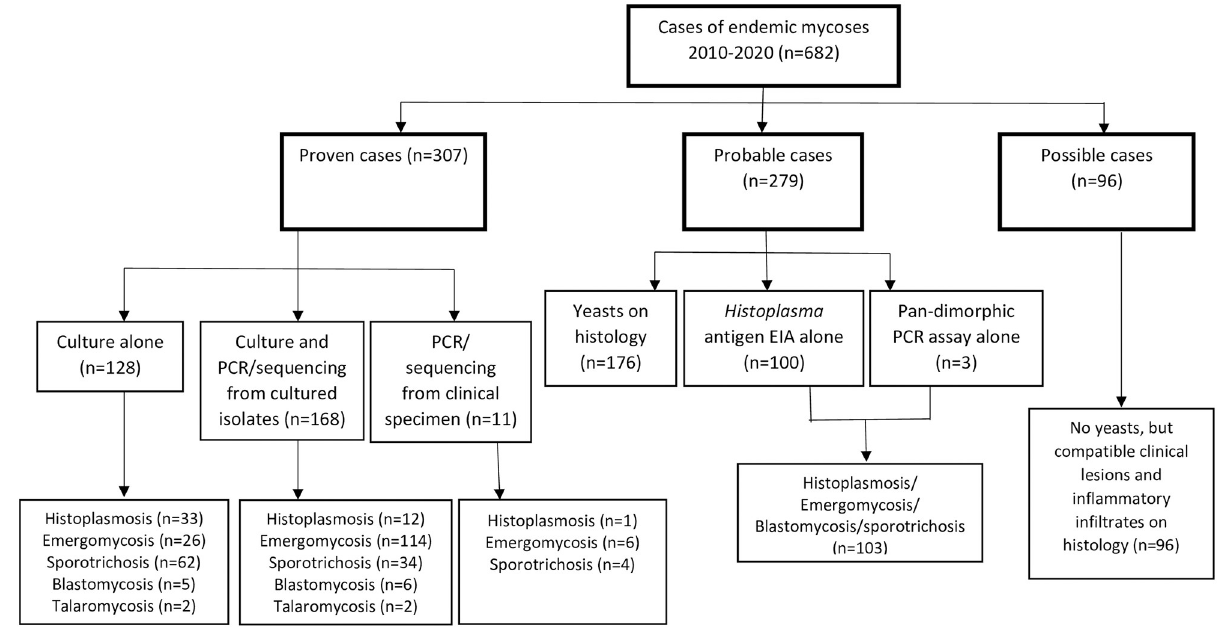
Fig 2. Flow chart showing levels of certainty for cases of endemic mycoses reported in South Africa from 2010–2020, n = 682.